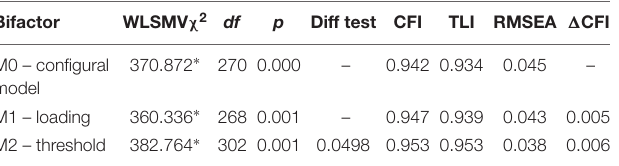
TABLE 4 | Fit indices for measurement